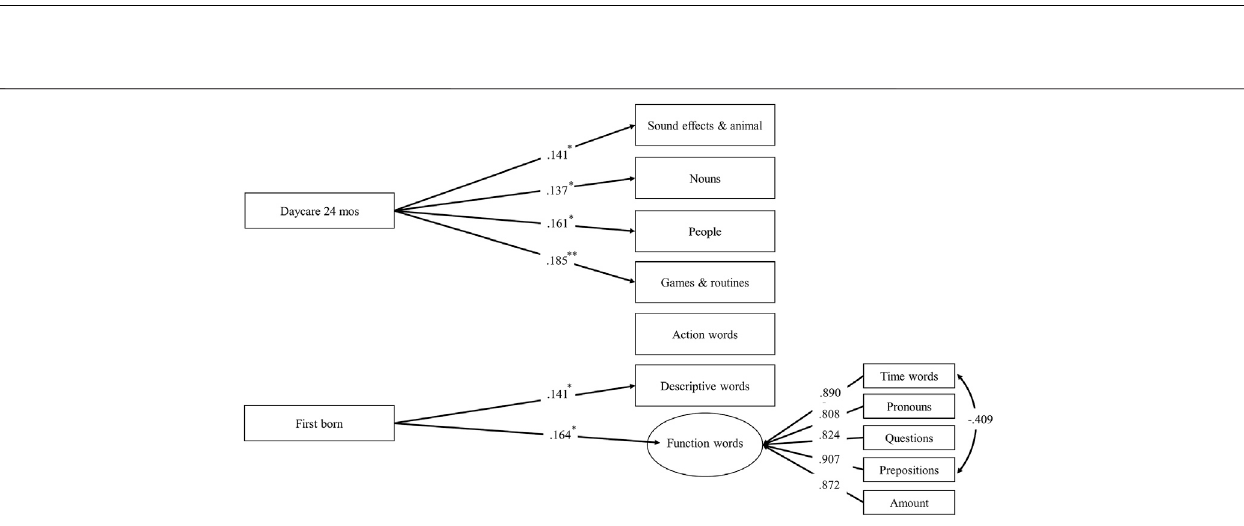
FIGURE 4 | Structural equation model including signi fi cant factors in predicting vocabulary growth in lexical categories in girls between ages 13 and 24 months. Note ( n (cid:1) 239); χ 2 (61) (cid:1) 156.38, p < 0.001, RMSEA (cid:1) 0.082, CFI (cid:1) 0.969, TLI (cid:1) 0.925, SRMR (cid:1) 0.018; Standardized coef fi cients. ** p < 0.001, * p < 0.05.